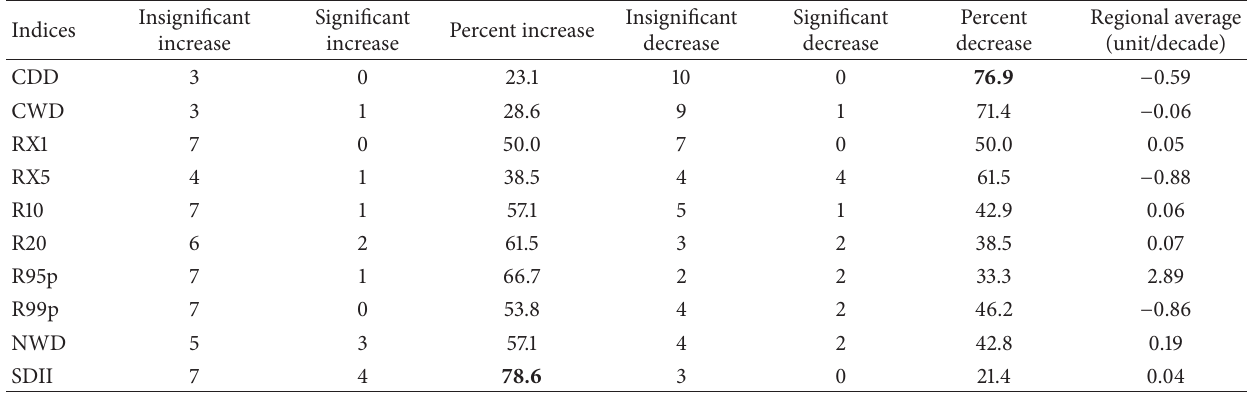
Table 6: Trend and regional averages of precipitation extreme